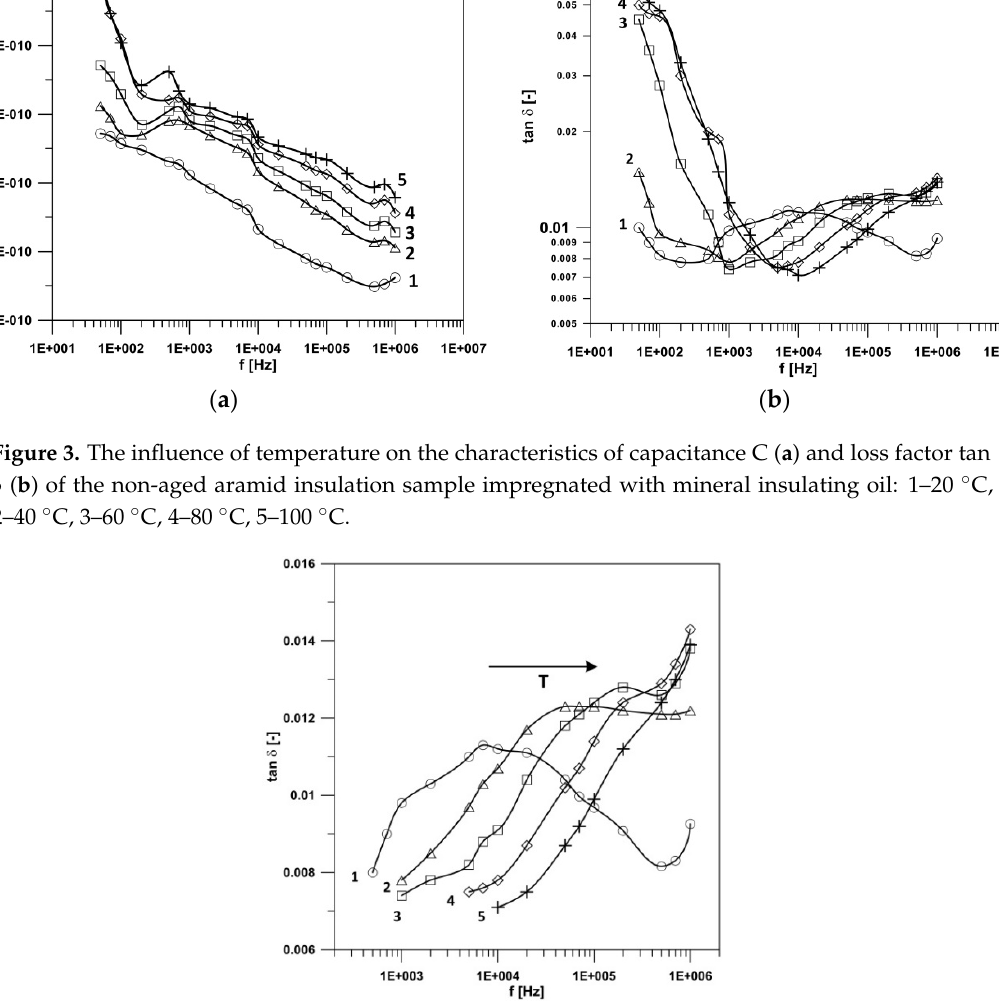
Figure 4. The influence of temperature on the characteristics of loss factor tan δ of the non-aged aramid insulation sample impregnated with mineral insulating oil: 1–20 °C, 2–40 °C, 3–60 °C, 4–80 °C, 5–100 °C.